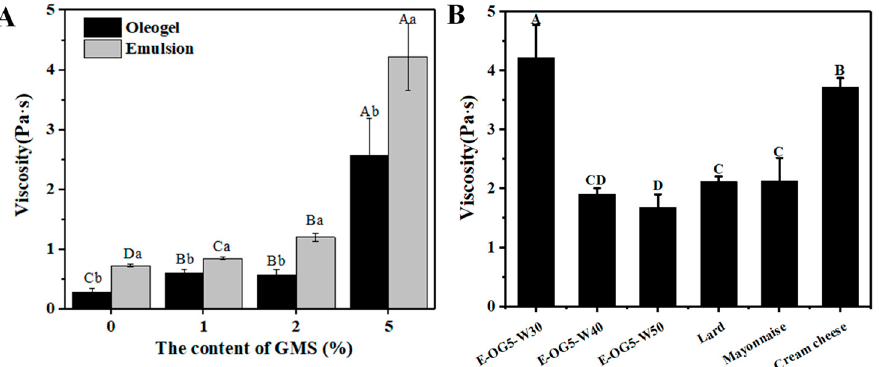
Figure 7. Shear viscosity as the rate of 50 s − 1 of oleogels and emulsions ( A ) and different water content of E-OG5 and products ( B ). ( A ): Different uppercase or lowercase letters represent significant differences of GMS content or oleogels and emulsions. ( B ): Different uppercase represent significant differences of samples, respectively ( p < 0.05).